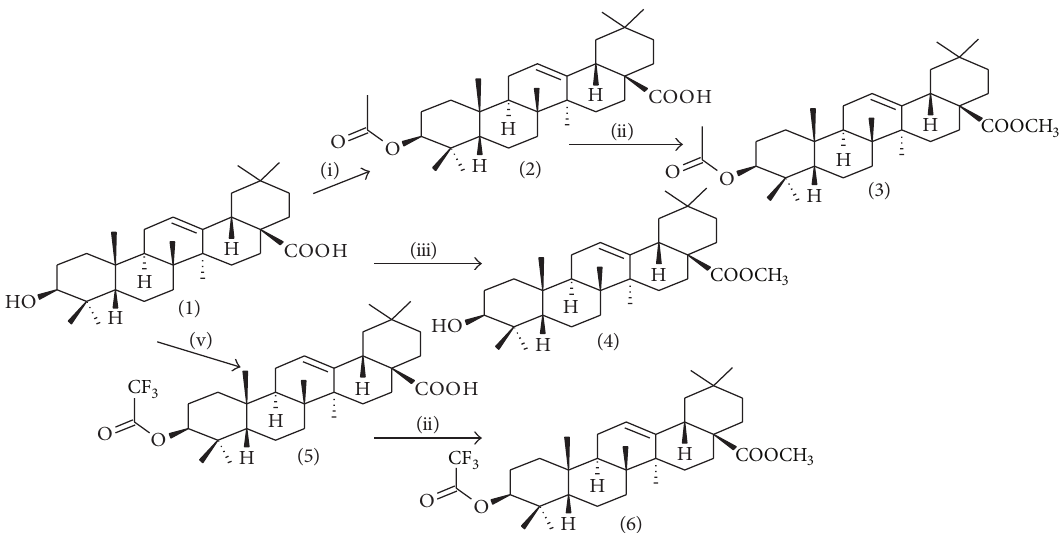
Figure 1: Semisynthetic pathways: (i) (CH 3 CO 2 ) 2 O, pyridine, 12hrs, 25 ∘ C, (ii) CH 3 I, DMF, 12hrs, 25 ∘ C, (iii) K 2 CO 3 , CH 3 I, 12hrs, 25 ∘ C, and